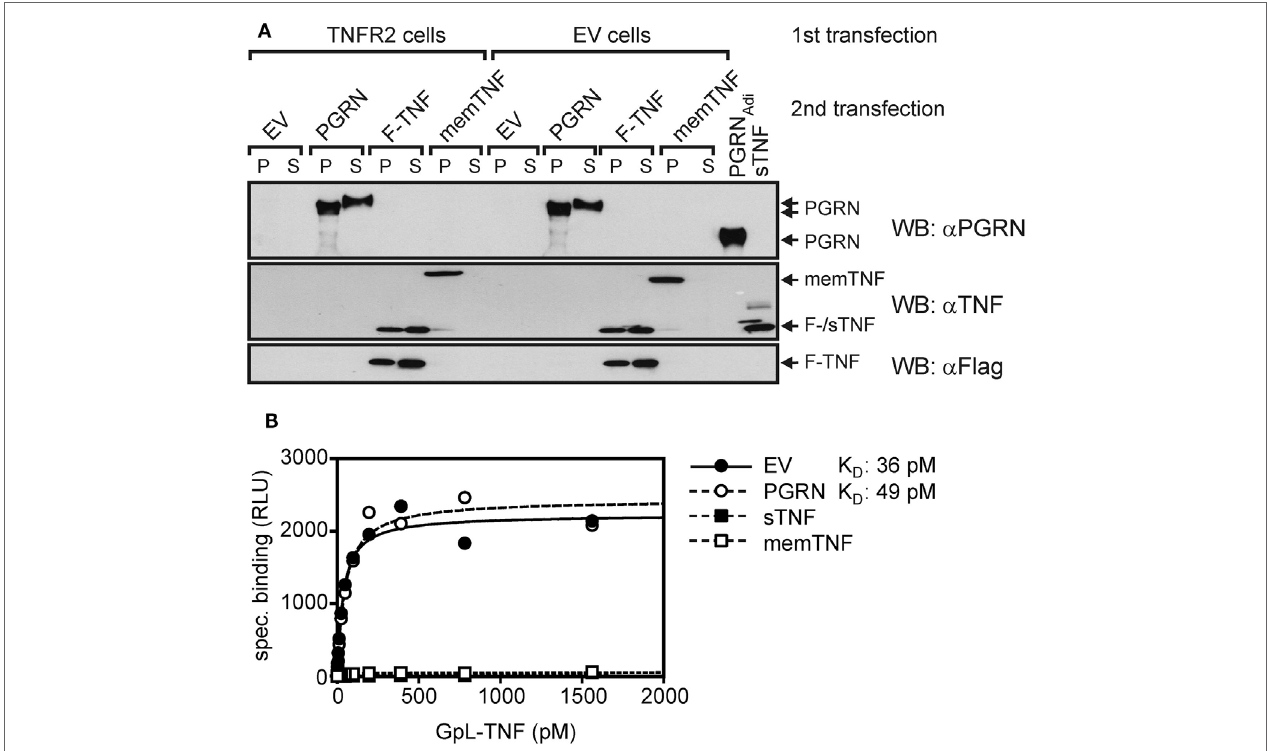
FigUre 3 | Gaussia princeps luciferase (GpL)-tumor necrosis factor (TNF) binding to cells with endogenous coexpression of tumor necrosis factor receptor-2 (TNFR2) and progranulin (PGRN). (a) Human embryonal kidney cells 293 (HEK293) cells were transfected (first transfection) with empty vector (EV) or an expression vector encoding TNFR2, where the TNF receptor associated factor 2 (TRAF2) binding site has been replaced by yellow fluorescence protein (YFP) (TNFR2). The following day, transfecfed cells were split into four aliquots which were transfected a second time (second transfection) with expression plasmids encoding PGRN, membrane TNF (memTNF), soluble Flag-tagged TNF (F-TNF), or EV. After an additional day, aliquots of 30,000 cells (P) and 15 µl SN (S) were analyzed by Western blotting with anti-PGRN, anti-TNF, and anti-Flag along with 100 ng PGRN Adi and 100 ng purified untagged soluble TNF (sTNF). (B) Equilibrium binding studies were performed with the indicated concentrations of GpL-TNF. Specific binding of GpL-TNF in the presence of PGRN (second transfection PGRN), membrane TNF (second transfection memTNF), and Flag-TNF (second transfection F-TNF) or the absence of an potential modulator (second transfection EV) was obtained by subtracting unspecific binding values (first transfection EV) from the corresponding total binding values (first transfection TNFR2). Specific binding values were fitted by non-linear regression analysis to a single binding site type of interaction by help of the GraphPad Prism 5